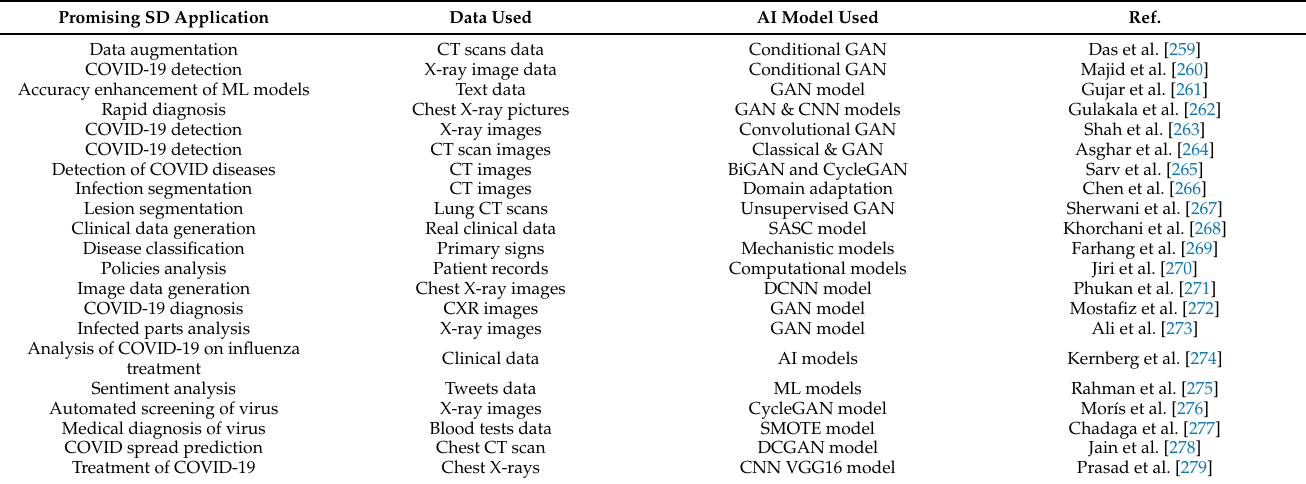
Table 6. Summary of promising applications of SD in the era of COVID-19.